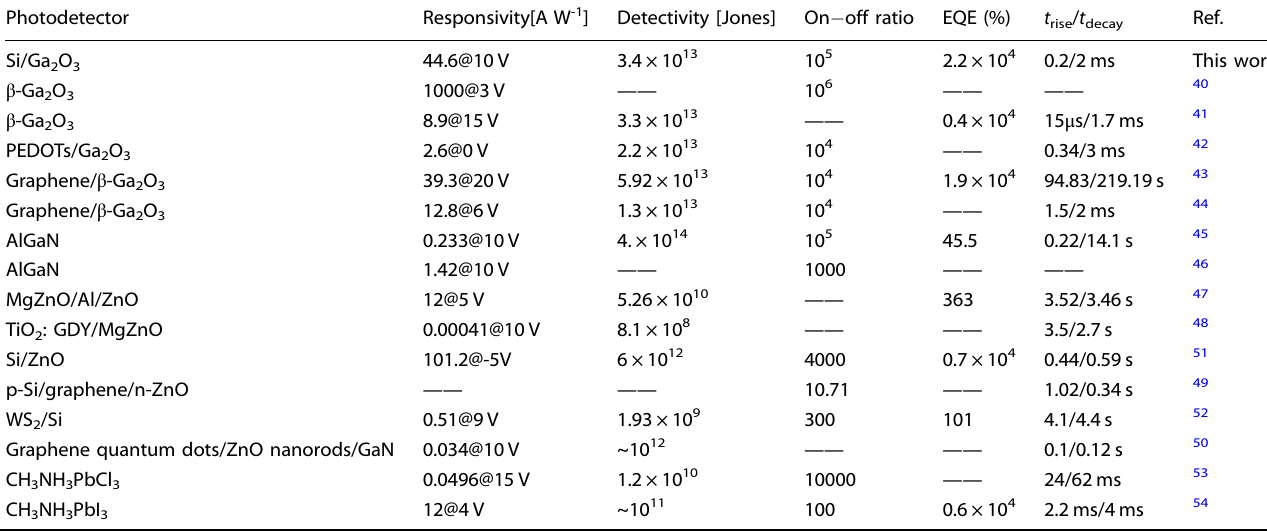
Table 1. Comparison of the most essential criteria of the photodetectors achieved in the current and previous investigations.